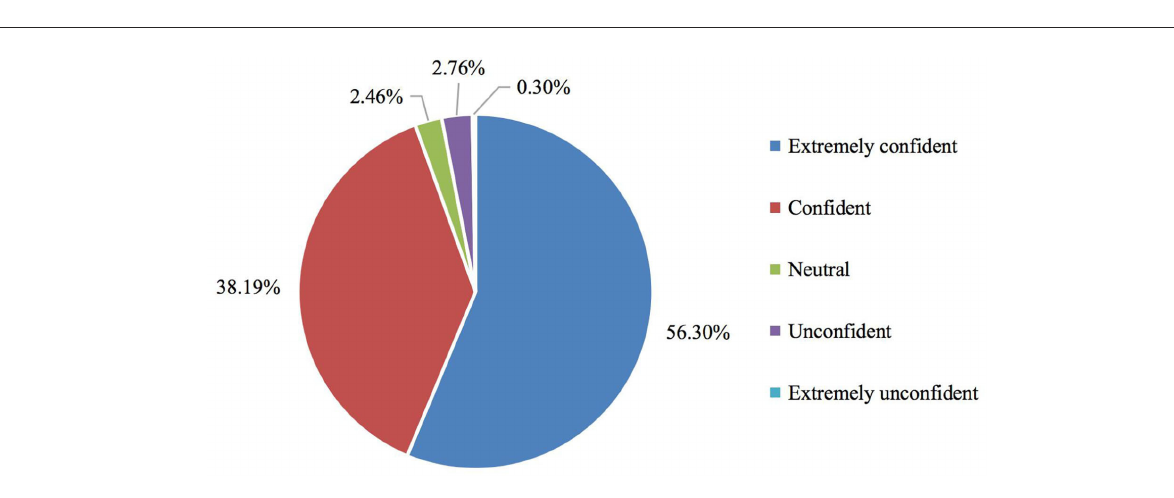
FIGURE3 Frequency distribution of residents’ confidence in controlling COVID-19 at the destination